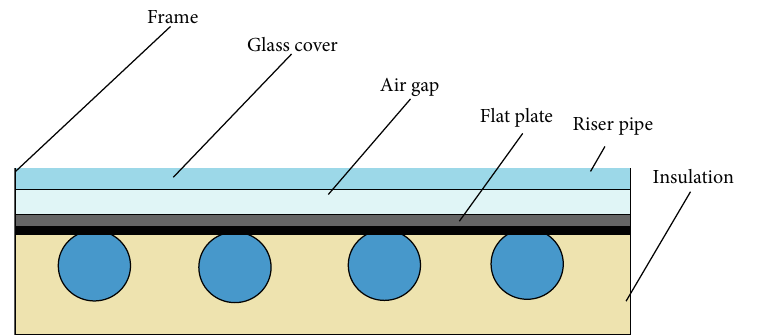
Figure 1: Schematic of a typical fl at plate collector.